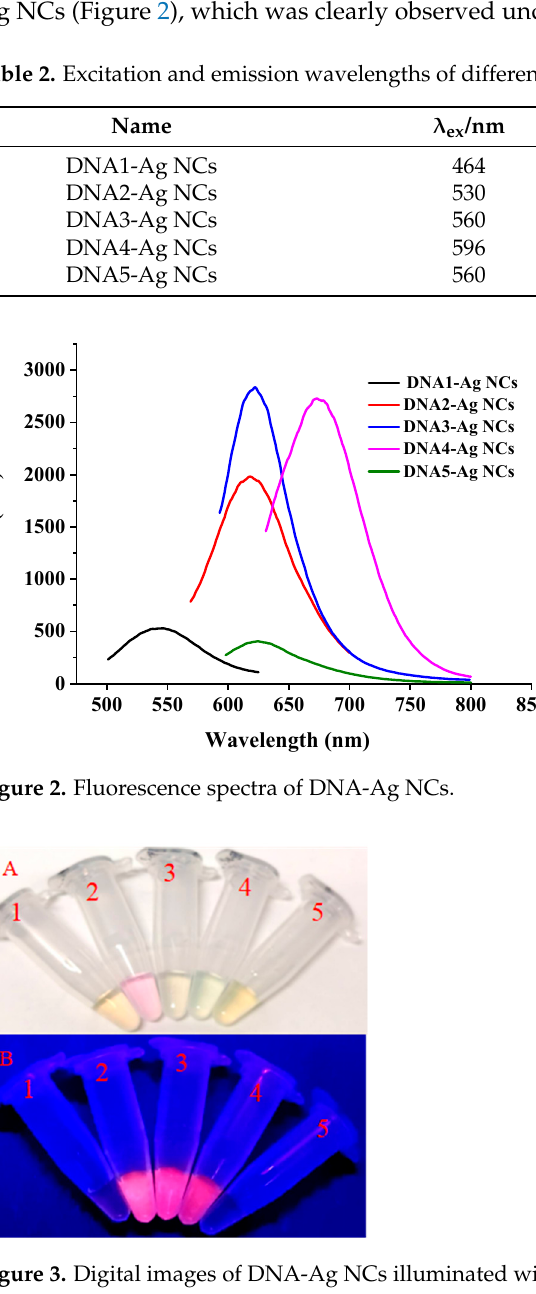
Table 1. Sequences of five single-stranded DNA.